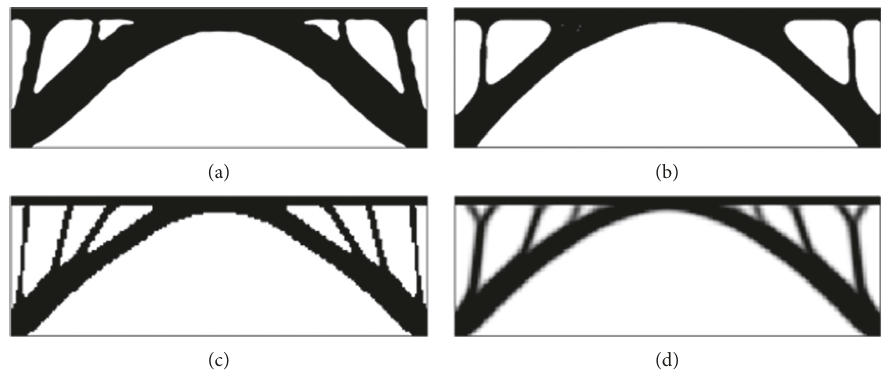
Figure 3: The optimal layout of deck arch bridge by different methods: (a) PLSM, (b) CLSM, (c) BESO, and (d) SIMP.